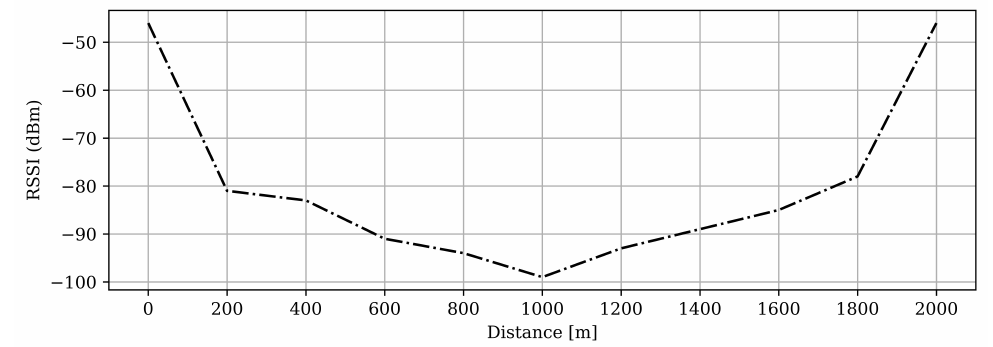
Figure 9. The RSSI values of the baseline scenario, the first half being the RSSI of GW-A and the second half